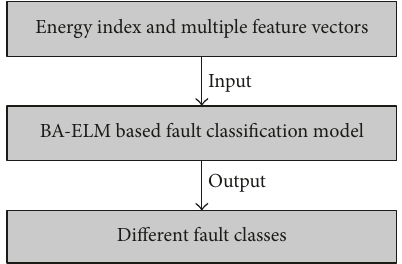
Figure 4: Flow chart of intelligent fault classification.